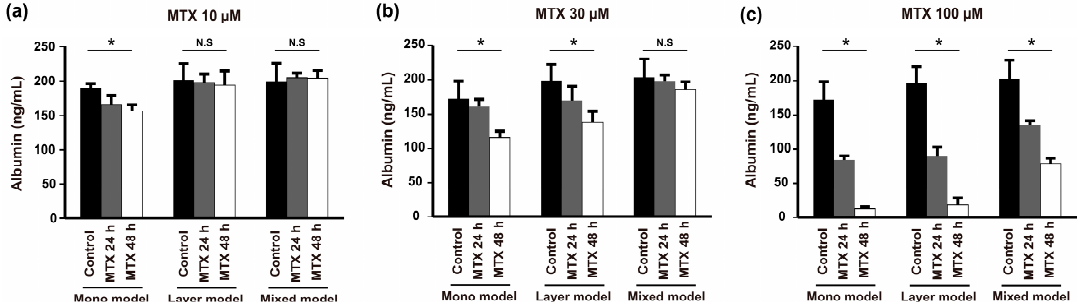
Figure 6. Anticancer drug resistance of Hep G2 cells determined in the mono model, layer model, and mixed model by measuring albumin secretion with increasing concentrations of MTX: ( a ) 10 µM; ( b ) 30 µM; and ( c ) 100 µM after 24 and 48 h. ( n = 3, * p < 0.05, N.S = not significant).